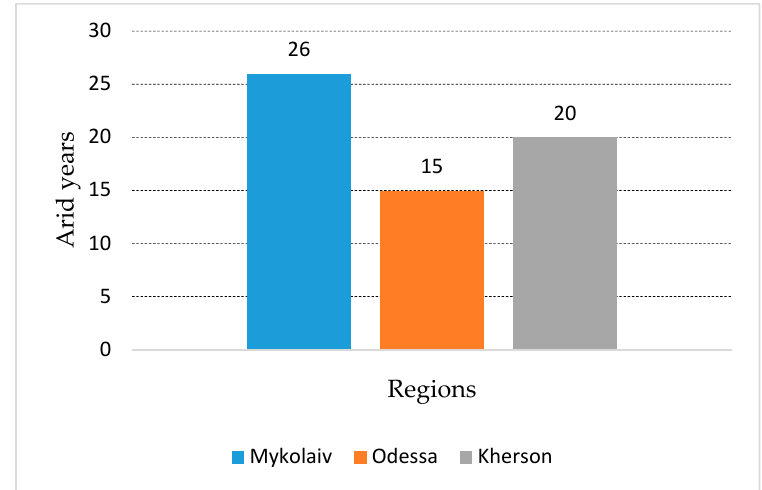
Figure 5. Arid periods for past 50 years, years. The average monthly precipitation and air temperatures are shown in Figure 6. The growth period of sorghum is from May to September, with most of the precipitation in June. The sum of rainfall during the growth period was 214 mm.